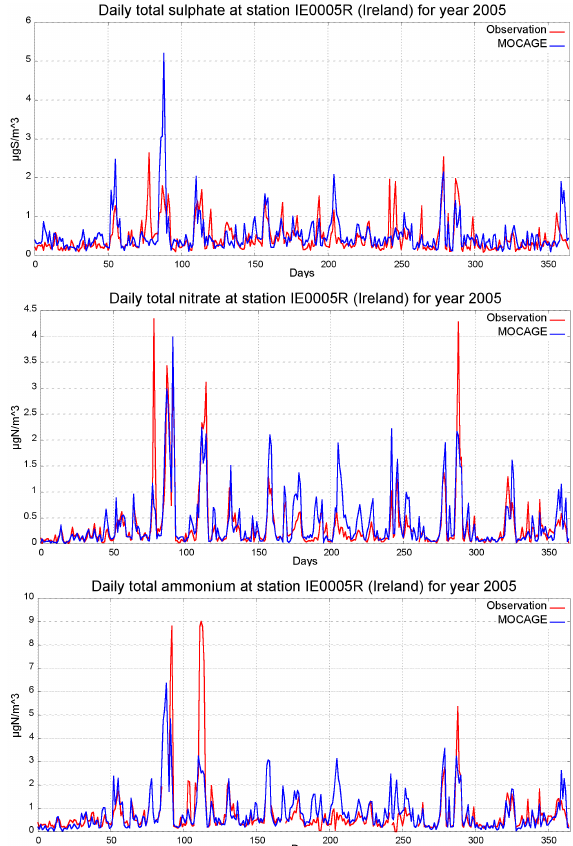
Figure 7. Time series of daily values (in µgm − 3 ) of sulfate (top panel), nitrate (middle panel) and ammonium (bottom panel) at an Irish station (52 . 87 ◦ N, 6 . 92 ◦ W) against the RACMSIA simulation for the year